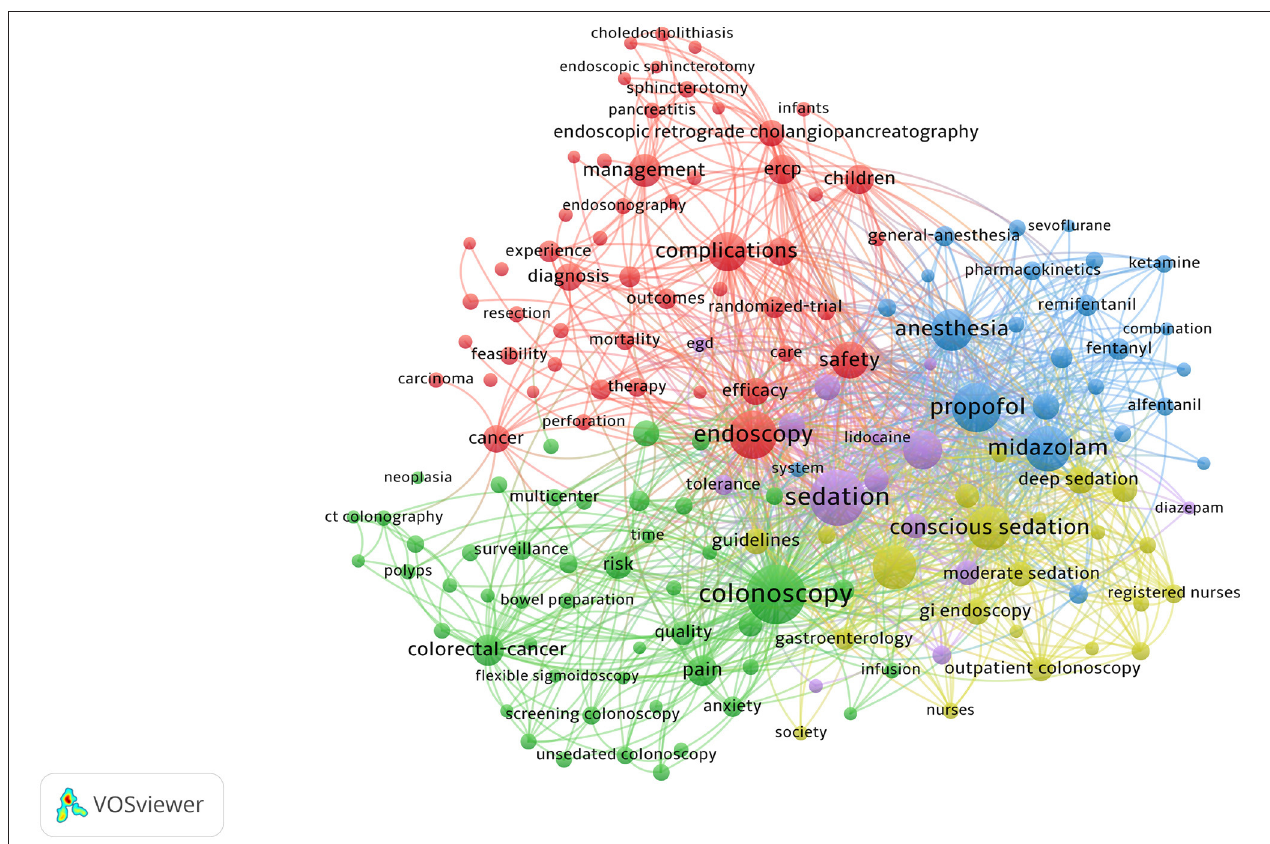
FIGURE 5 | The network map of keyword clustering showed 161 keywords with a minimal occurrence of 25 times and classified into five